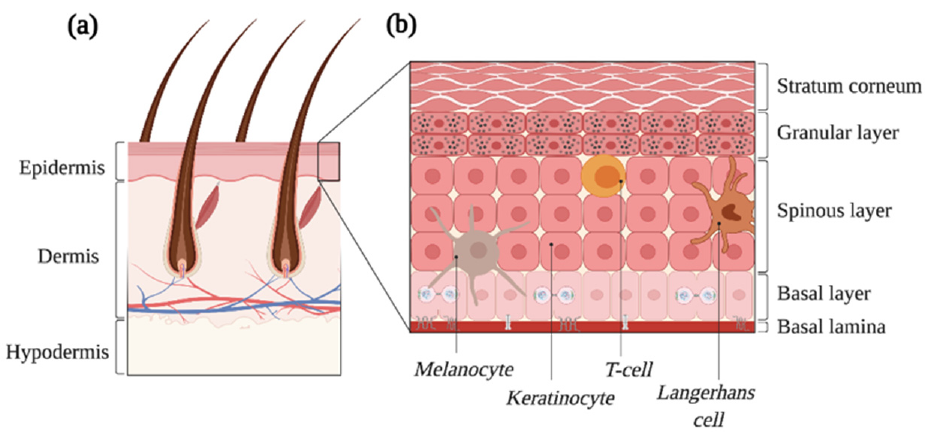
Figure 1. The skin is the largest organ of the human body. ( a ) The adult skin is formed of three compartments, i.e., the epidermis, the dermis and the hypodermis. Several cell types and epidermal appendages, such as the hair follicles depicted here, achieve all the skin’s essential functions. ( b ) The epidermis is a complex epithelium formed of four layers, namely the basal, the spinous, the granular and the stratum corneum as well as multiple cell types. Proliferation occurs in the basal layer, and the balance between the self-renewal and differentiation of progenitors ensures skin regeneration. Created with BioRender.com, accessed on 20 August 2021.